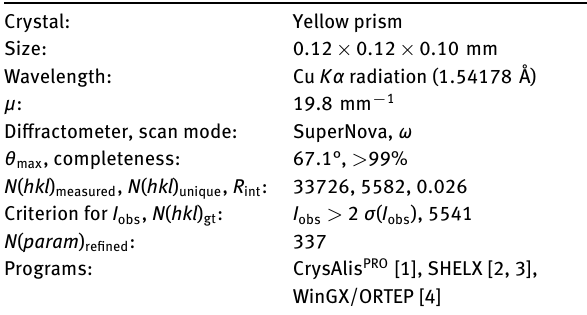
Table 1: Data collection and